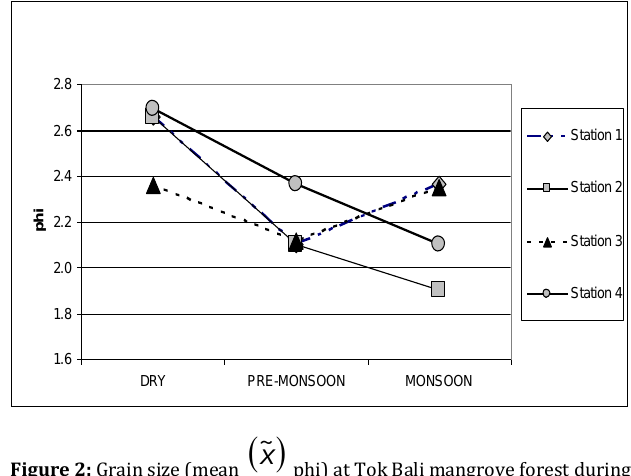
( ) x ~ Figure 2: Grain size (mean phi) at Tok Bali mangrove forest during all seasons 3.2.2 Total Organic Matter (TOM) The average for TOM percentage during a dry sampling session was 1.42 the average decreased to 0.667 g/g. Overall, the percentage of TOM is highest during pre-monsoon. The percentages of TOM at all stations were low and show decreasing pattern during the monsoon sampling session (Figure 3).